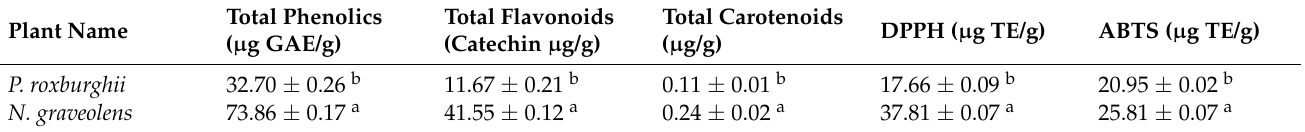
Table 2. Phytochemical analysis and antioxidant activities of P. roxburghii and N. graveolens